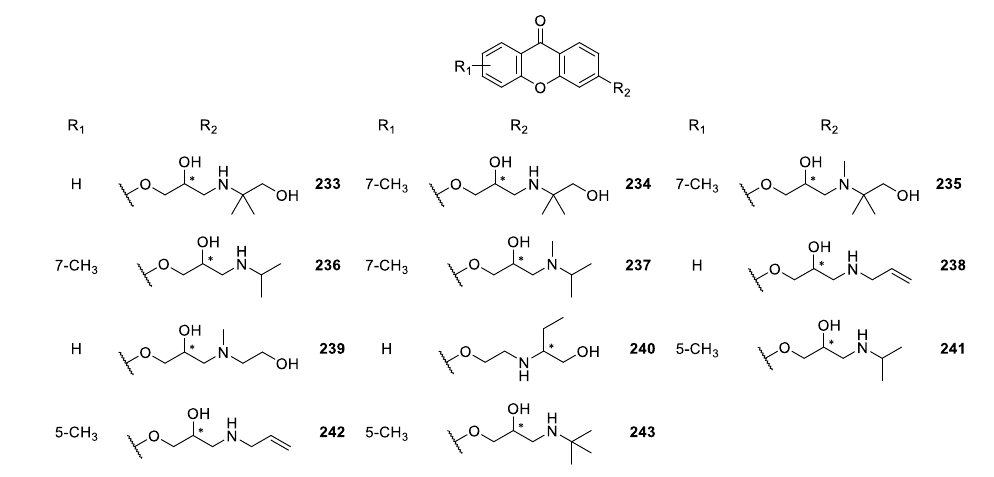
Figure 20. Structures of 3-aminoalkanolic CDXs 233 – 243 .